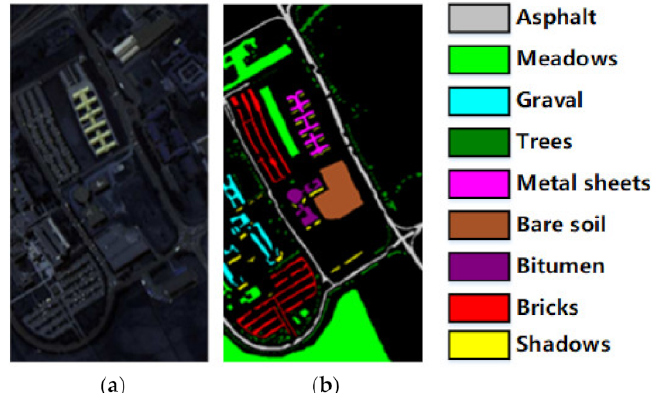
Figure 8. University of Pavia. ( a ) False-color image. ( b ) Ground-truth